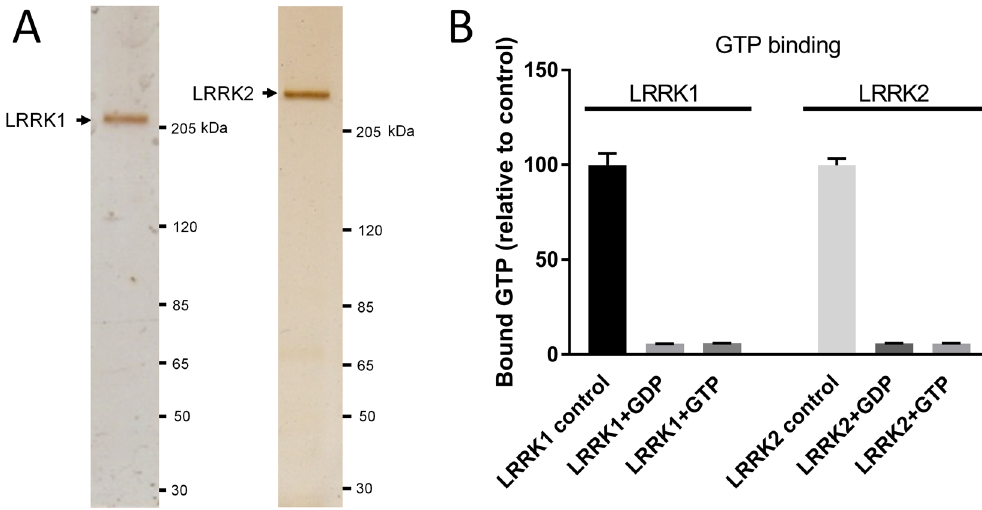
Figure 3. Expression and purification of full-length 3xflag-LRRK2 and 3xflag-LRRK1. ( A ) Silver stained gel of 3xflag-LRRK2 and 3xflag-LRRK1 purified as described in Materials and Methods . In both cases, the protein concentration was 10 μ g/ml and a 10 μ l aliquot was added to the gel. The dominant bands observed at the molecular weights 215 and 285 kDa are 3xflag-LRRK2 and 3xflag-LRRK1, respectively, indicating highly pure protein fractions. Markers are in kiloDaltons. ( B ) Functionality of the purified 3xFlag-LRRK1 and 3xFlag- LRRK2 proteins was assessed using a radiometric GTP binding assay as described in materials and methods. Proteins were incubated at 30 °C with GTP- α -P32 alone or with addition of 200 mM ‘cold’ nucleotides. After incubation, excess nucleotides were rinsed away and the amount of bound isotopic GTP was measured via scintillation counting and expressed as binding level relative to control protein (n =